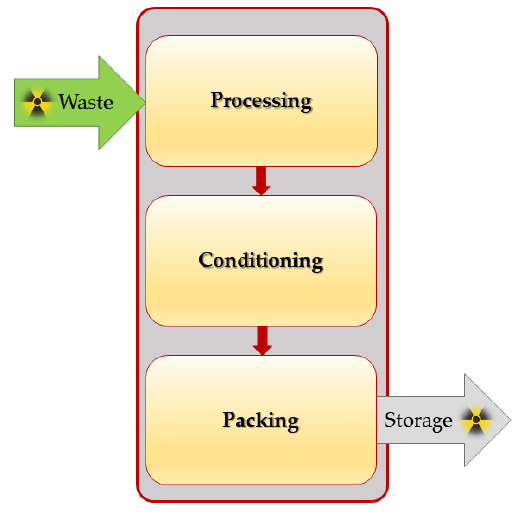
Figure 8. Direct disposal of small graphite